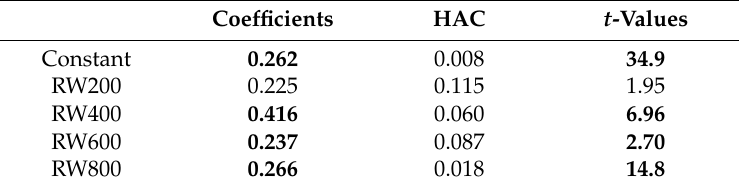
Table 11. OLS Estimates from Equation (4) (bold denotes significance).